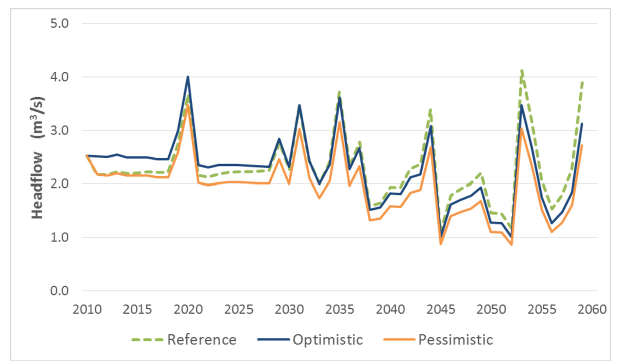
Figure 3. Average annual simulated headflows produced by páramo’s catchments of Quiroz-Chipillico watershed model.